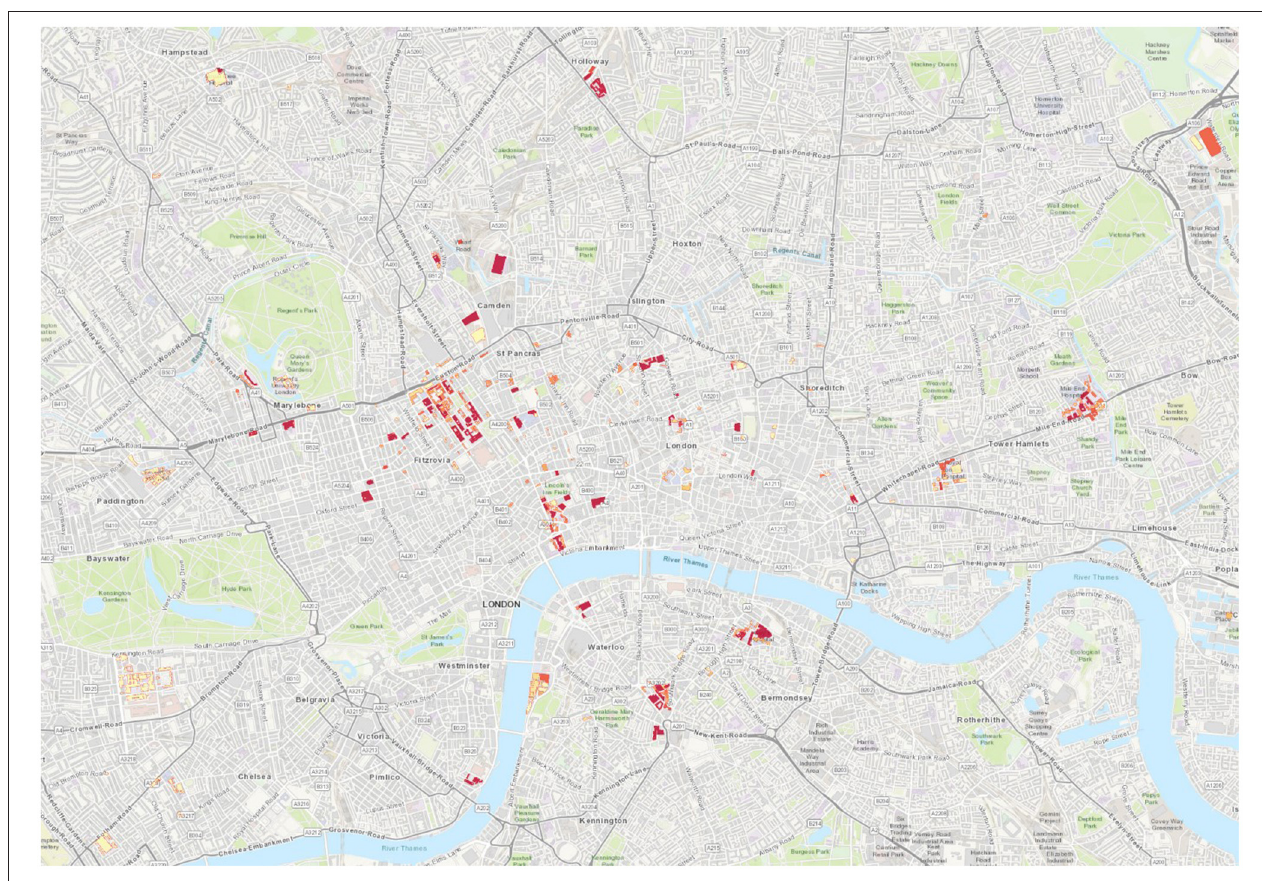
FIGURE 1 | Indication of university estates in Central London